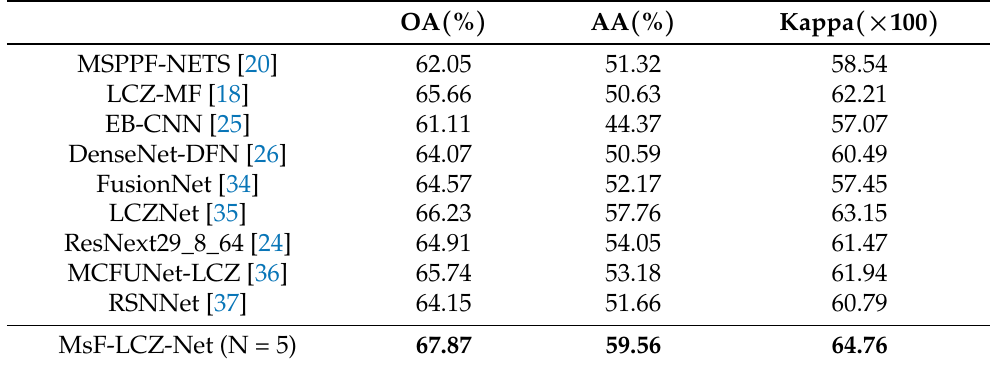
Table 4. Classification performance comparison with other state-of-the-art methods on the So2Sat LCZ42 dataset.